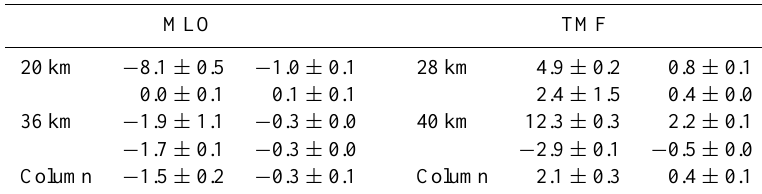
Table 4. Summary of the extreme annual mean values of the ozone response to the ODGI (lidar values are for each altitude on the first line, satellite below and linear on the right). Results calculated from the lidar stratospheric ozone column from 20 to 40km were added on the bottom of the table. Units are in % by decade.